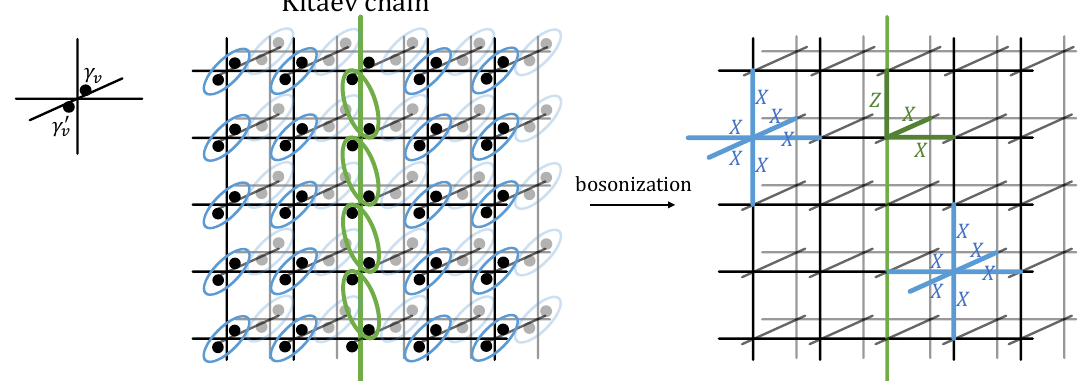
Figure 15: This is the summary of 3d bosonization on the cubic lattice. There are two Majorana fermions γ , γ ′ at each vertex v , and a qubit on each edge e , described v v by the Pauli matrices X , Y , Z . The mapping between the Majorana operators and e e e Pauli operators is shown above. The fermionic hopping operators i γ edge e = 〈 i j 〉 are mapped to the Pauli hopping operators: Pauli Z Pauli X matrices on edges crossing the “framing” of edge e . The on-site fermion parity = − i γ γ ′ P at the vertex v is mapped to the X -star term. On the fermionic side, we v v v (cid:81) = + 1. On the other hand, the bosonic side is P focus on the even subspace, i.e., v v restricted to the subspace satisfying the gauge constraints.